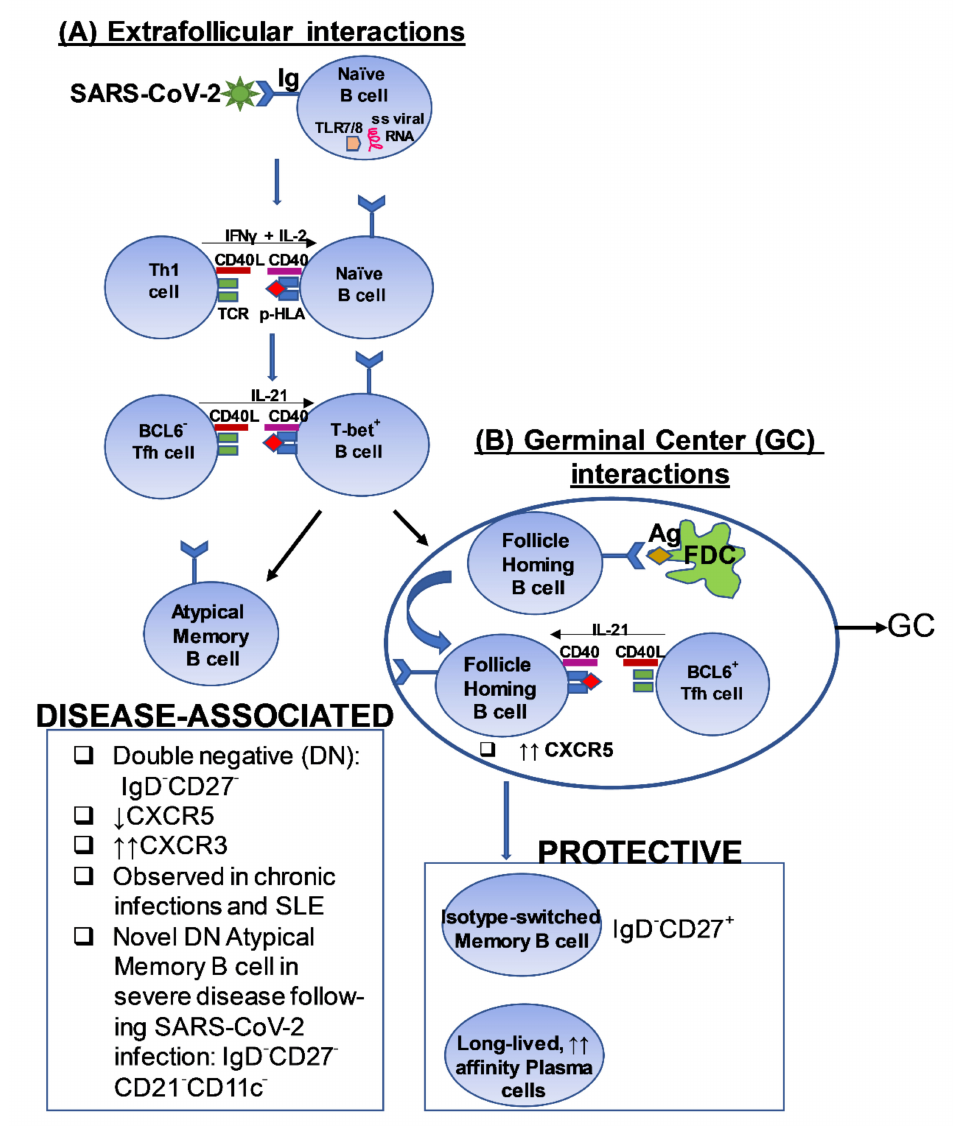
Figure 2. A proposed model depicting a potential pathway of cross-talk between T cells and B cells in the context of SARS-CoV-2 infection [102–106]. The figure outlines a putative pathway that induces the generation of ( A ) Disease-associated B cells observed in the setting of severe disease and, ( B ) Protective B cell responses, following exposure to SARS-CoV-2. FDC: Follicular dendritic cell; TLR: Toll-like receptor; TCR: T cell receptor; p-HLA: peptide-Human leukocyte Antigen complex; BCL6; B cell lymphoma 6 protein; CXCR5: C-X-C chemokine receptor 5; CXCR3: CXCR5: C-X-C chemokine receptor 3; Tfh: T follicular helper; SLE: Systemic Lupus Erythematosus; ss: